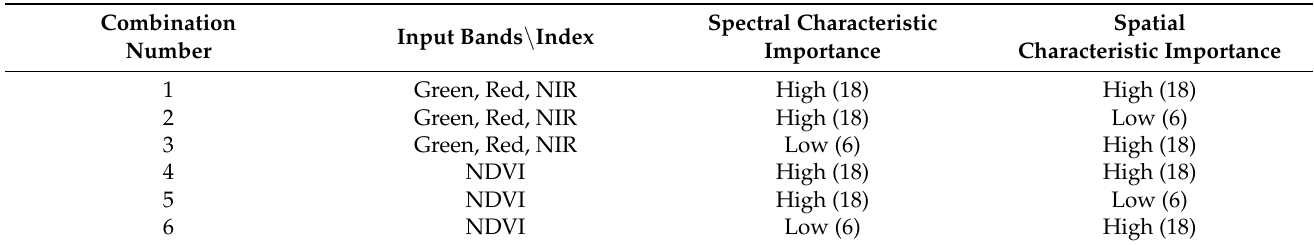
Table 1. Characteristics importance (spectral and spatial) and input (image bands or VI) combinations tested using mean shift